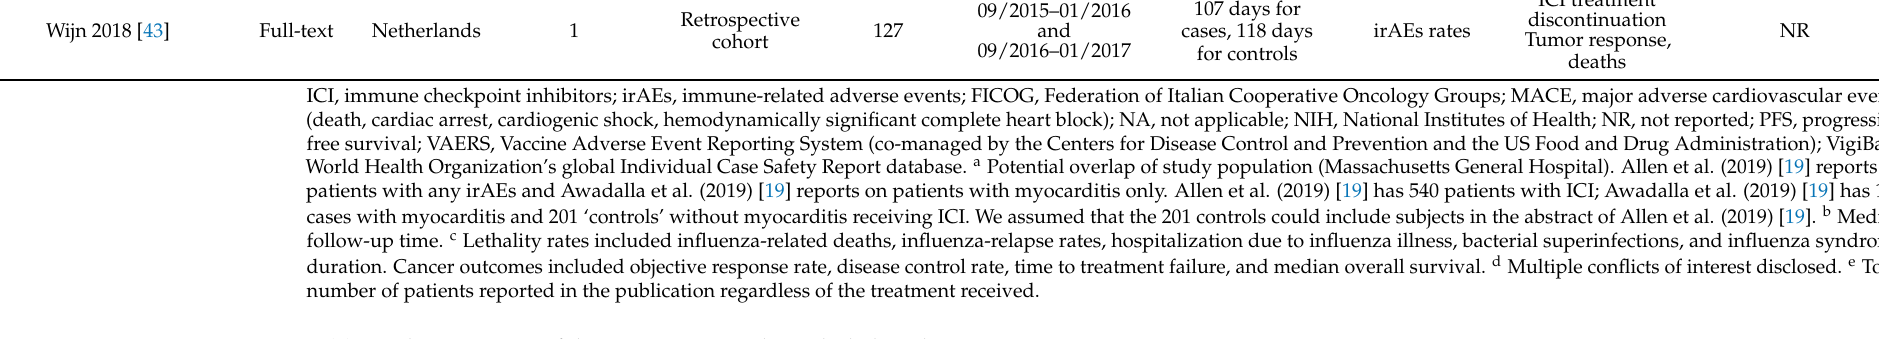
Table 2. Characteristics of the participants in the included